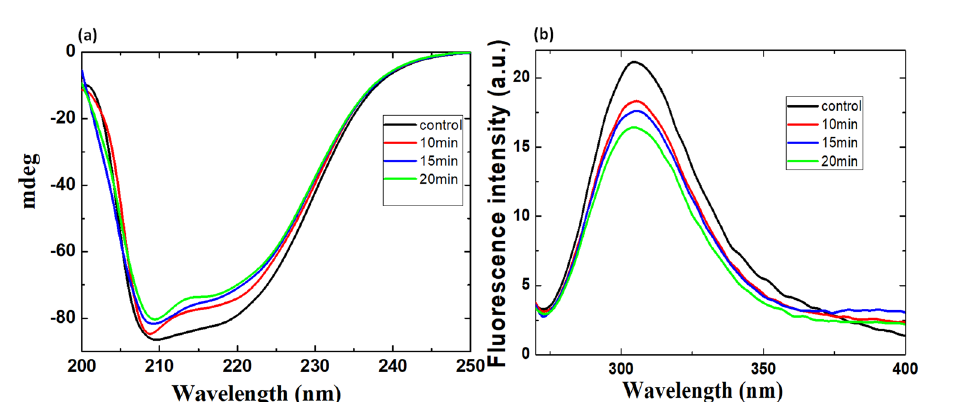
Figure 2. ( a ) Far CD spectra and ( b ) fluorescence spectra of MTH before (“control”) and after plasma treatment for different